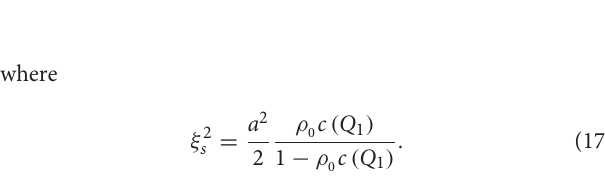
Near the glass transition E a ( T ) for Pd 42.5 Ni 7.5 Cu 30 P 20